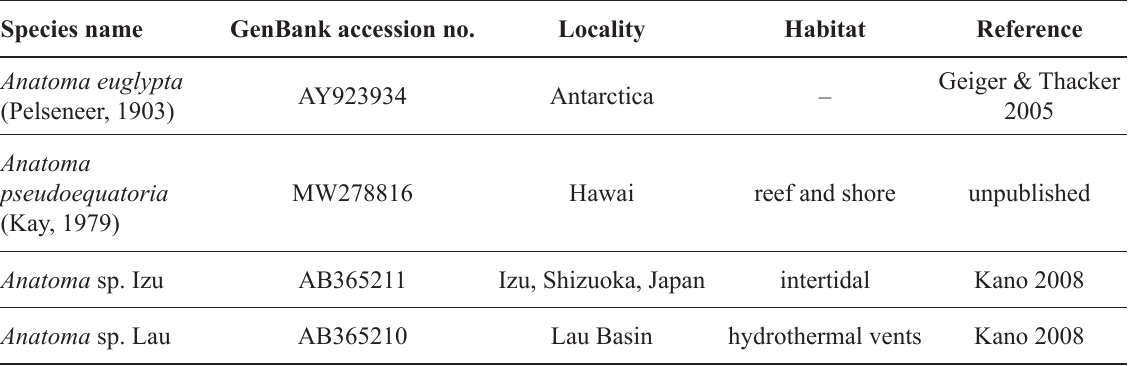
Table 2. List of COI sequences from GenBank for the genus Anatoma Woodward, 1859 used for the molecular analyses in this study. Species name, GenBank accession number, locality, habitat and reference are